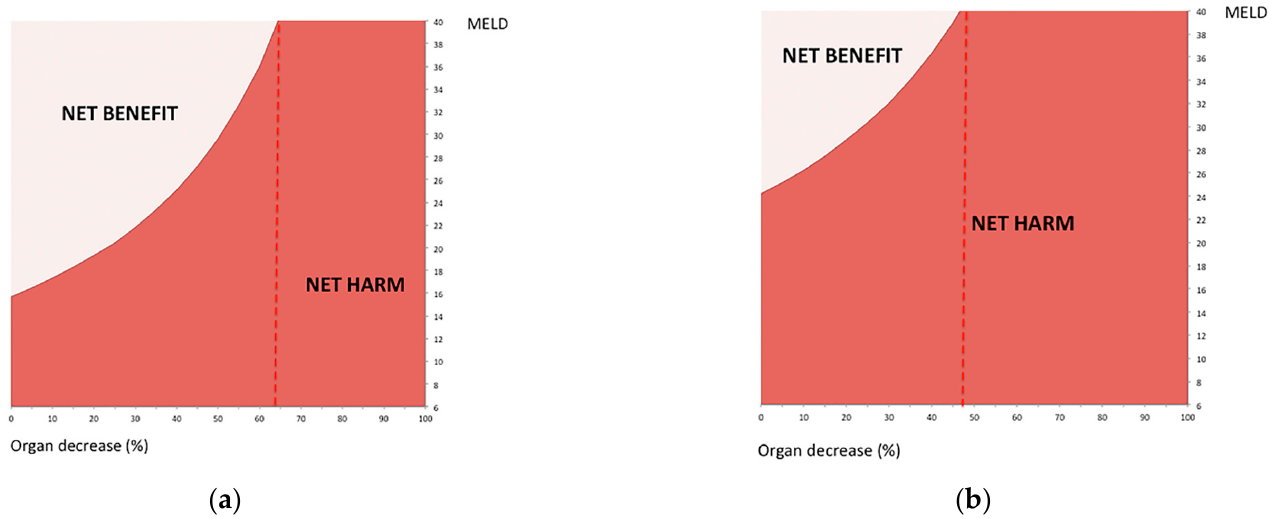
Figure 4. Impact of acute organ shortage due to COVID-19 pandemic on MELD score threshold values to decide organ allocation in T2 HCC ( a ) and non-HCC ( b ) patients.